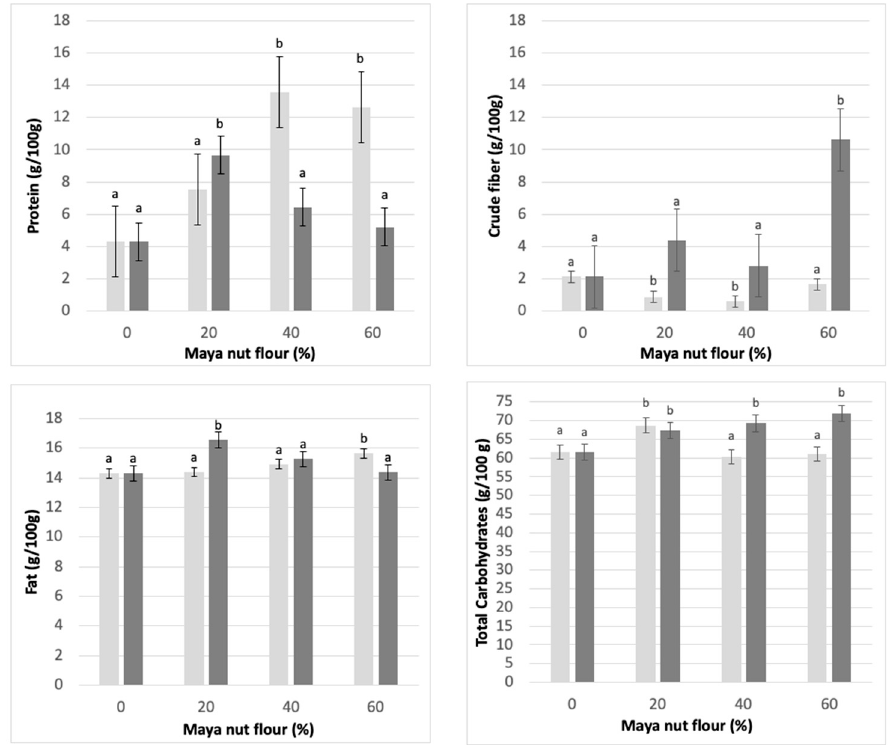
Figure 5. Important nutritional components in Maya nut cookies. NF (light-colored bar graph), naturally sun-dried flour and CF (dark bar graph), commercial flour. Maya nut flour: 0%, 20%, 40%, and 60%. Different letters indicate significant difference ( p < 0.05).